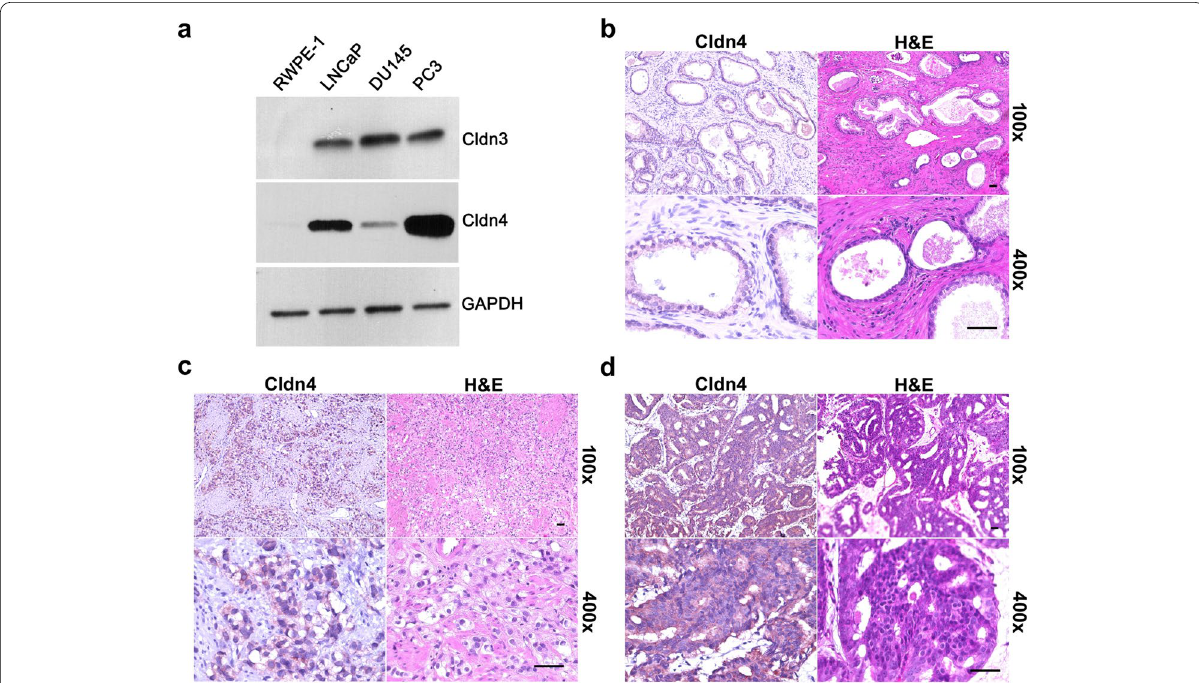
Fig. 1 Cldn expression in human prostate cells and tissue specimens. a The levels of Cldn3 and Cldn4 were higher in metastatic human prostate cancer (PC3, LNCaP, and DU145) cells compared to benign prostate (RWPE-1) cells. Immunohistochemistry was performed on ( b ) human benign prostatic hyperplasia specimen, ( c ) human high-grade prostate cancer specimen 1 (Gleason grade group 4 cancer specimen 2 (Gleason grade group 4 ) for Cldn4 (brown). Representative H&E and IHC staining are shown at 100 + bars 50 =